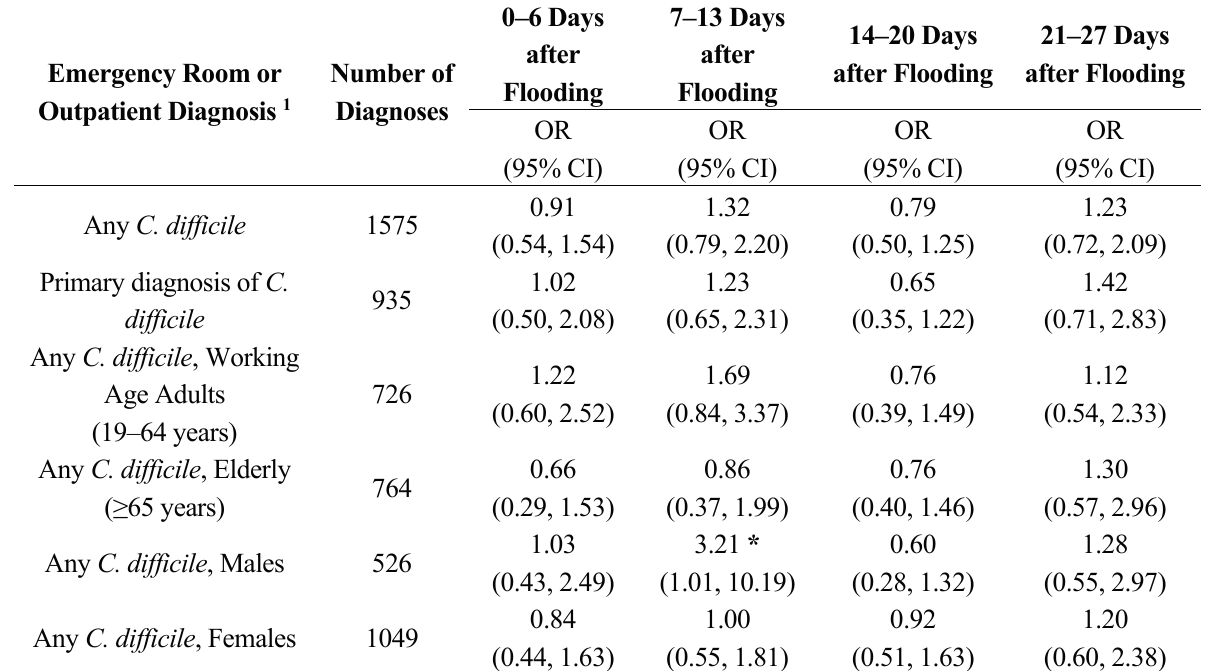
Table 3. Association between flooding and diagnoses for Clostridium difficile at Massachusetts health care